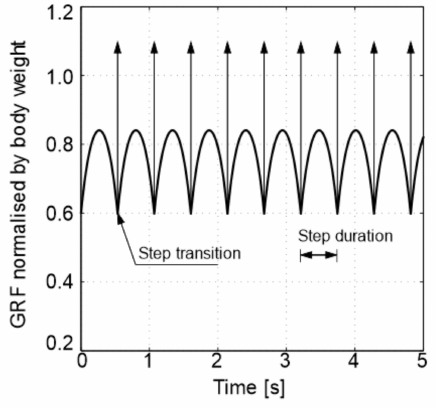
Figure 7. Normalised GRF as a function of